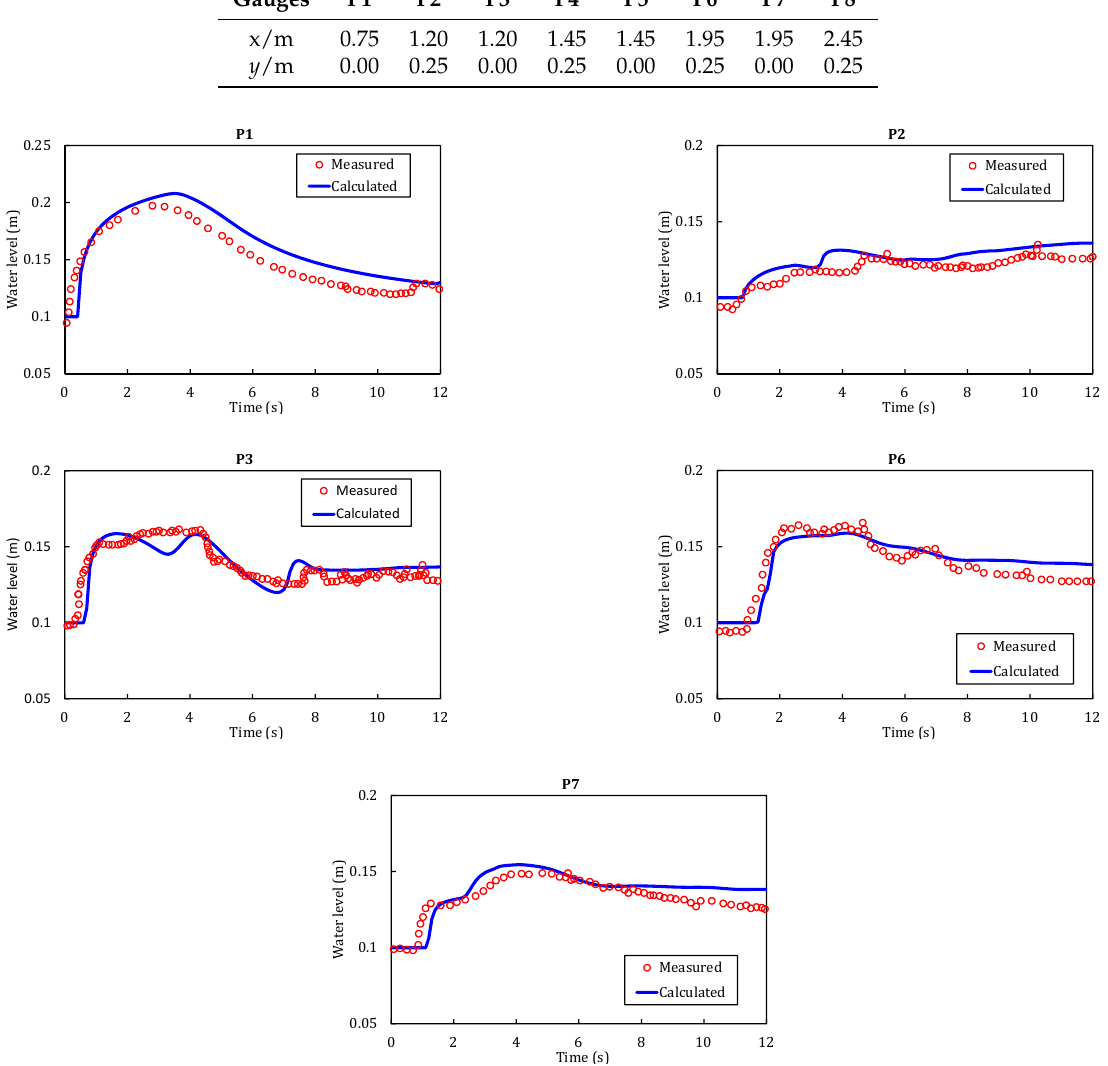
Figure 11. The measured and calculated water level at gauge P1, P2, P3, P6 and P7 in a period of 12